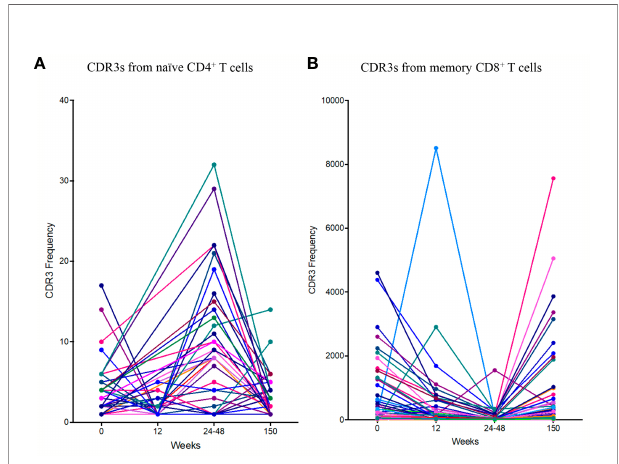
FIGURE 4 | The dynamics of the public TCR repertoire during PTI. The y axis shows the abundance of TCRs shared by all four PTI individuals at one or more time points. (A) Naïve CD4 + TCR repertoires and (B) Memory CD8 + TCR repertoires. Annotated CDR3s from the VDJ database are listed with corresponding amino acid sequences, epitopes, TCR population and chain ( Table 2